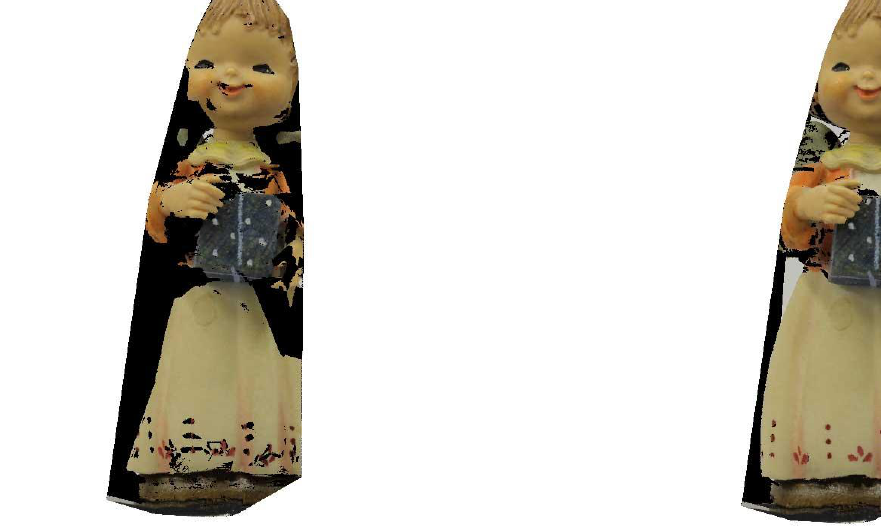
Figure 10. Areas which are not obtained data from the triplet images.